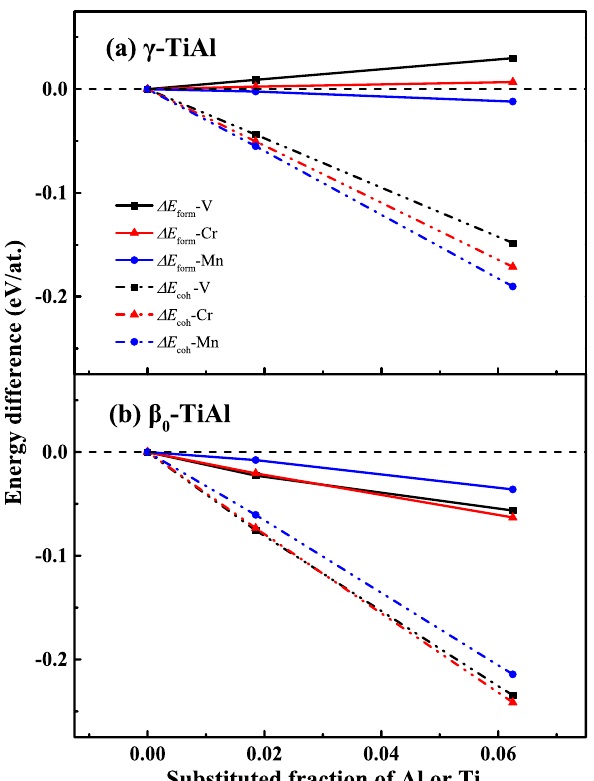
Figure 1. Calculated formation E form and energies E coh of X = V, Cr, and Mn sitting at Al and Ti sites in γ ( a ) and β 0 ( b ) phases as a function of composition. The relative energy ΔE denotes the energy difference between Al-site and Ti-site, and positive (negative) value means that Ti (Al) site is energetically favored. To simulate the low level doping 3 × 3 × 3 (1.825 at.%) and 2 × 2 × 2 (6.25 at.%) supercells are constructed with the central atom replaced by